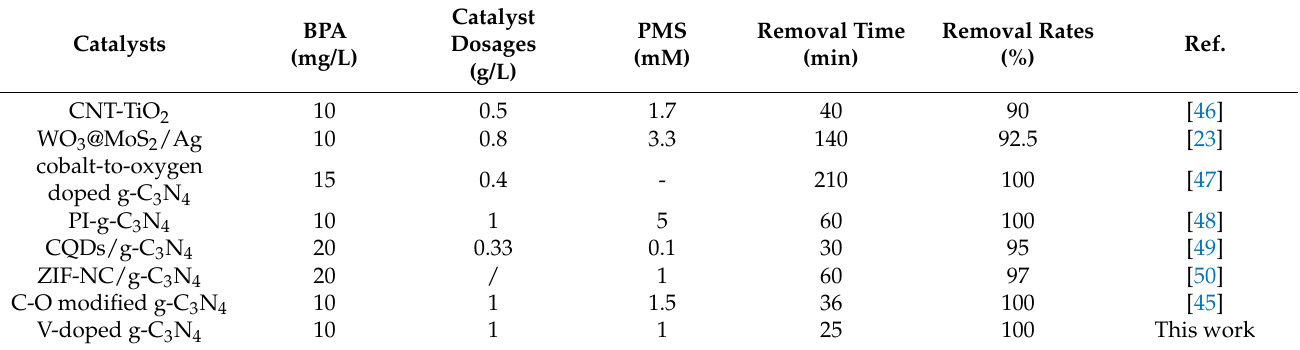
Figure 8. HPLC spectra of BPA degradation over the V-g-C 3 N 4 -0.5 with PMS activation. Table 1. A comparison of the catalytic performance with other works.